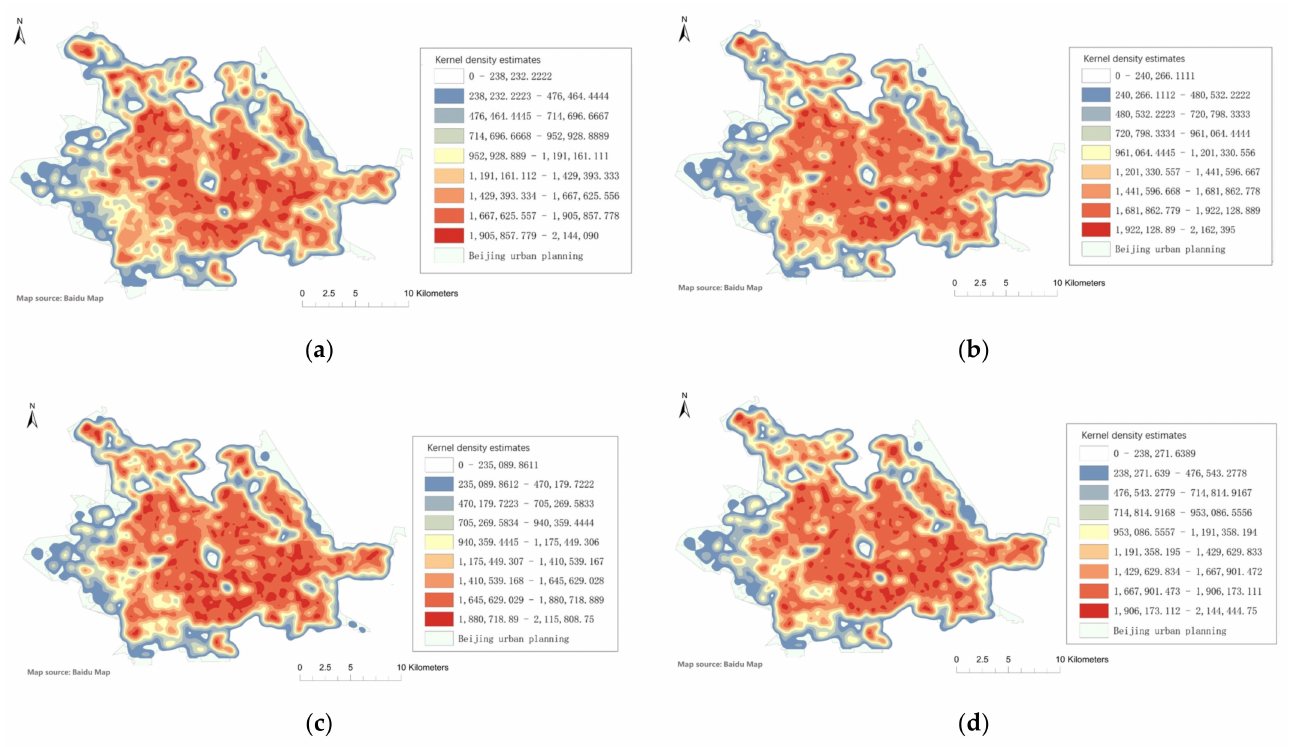
Figure 2. Heat map of shared bicycle spatial distribution at 17:00 and 20:00 from 19 May 2021 to 22 May 2021: ( a ) 17:00 19 May 2021; ( b ) 20:00 19 May 2021; ( c ) 17:00 22 May 2021; ( d ) 20:00 22 May